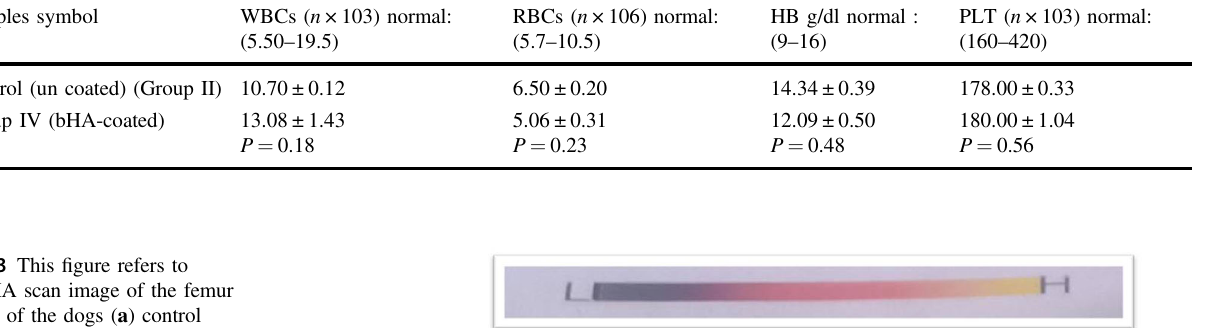
Fig. 3 This fi gure refers to DEXA scan image of the femur bone of the dogs ( a ) control group I ( b ) group III ( c ) control group II ( d ) group IIII. The relative areal of bone mineral density (BMD) is indicated by: H high density, L low density appearance of yellow color indicate high bone mineral density of femur bone, range on the bar change from dark color to yellow color taken from instrument